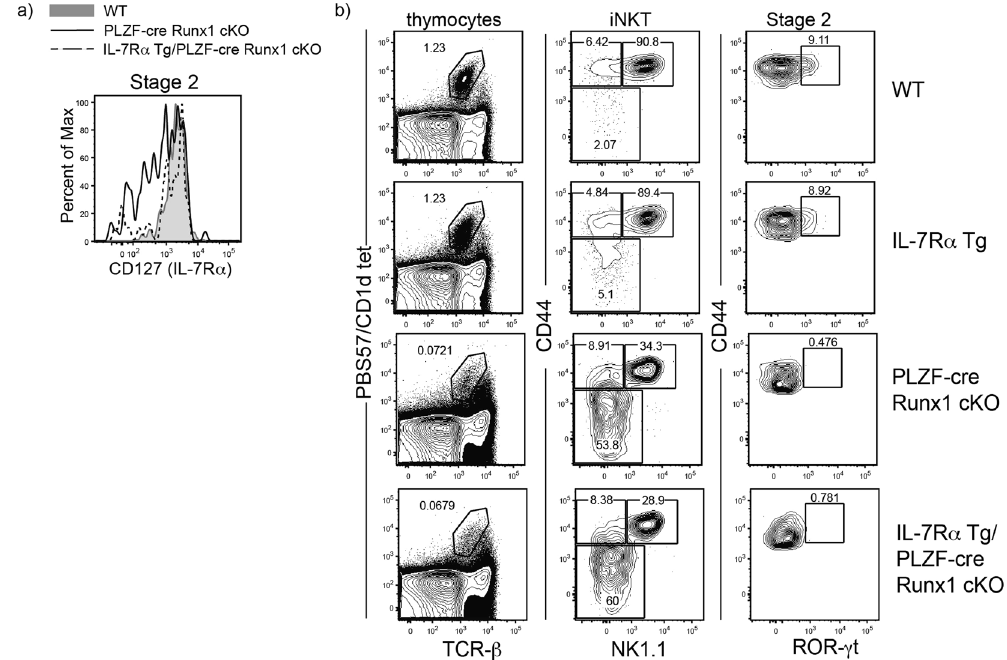
Figure 5. Transgenic expression of IL-7R α in PLZF-cre Runx1 cKO mice does not rescue block in iNKT17 differentiation. ( a ) Expression of IL-7R α in Stage 2 iNKT cells from WT (grey tint) and PLZF-cre Runx1 cKO (black line) and IL-7R α Tg/PLZF-cre Runx1 cKO (dashed line) mice. Data is representative of 3 mice/ genotype from 2 independent experiments. ( b ) FACS analysis of iNKT cell development in WT, IL-7R α Tg, and IL-7R α Tg/PLZF-cre Runx1 cKO mice. Analysis of iNKT cells was performed as described in Fig. 1. Data is representative of 3 mice/genotype from 2 independent